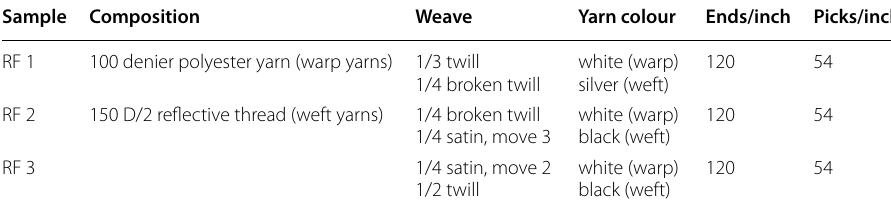
RF means Reflective